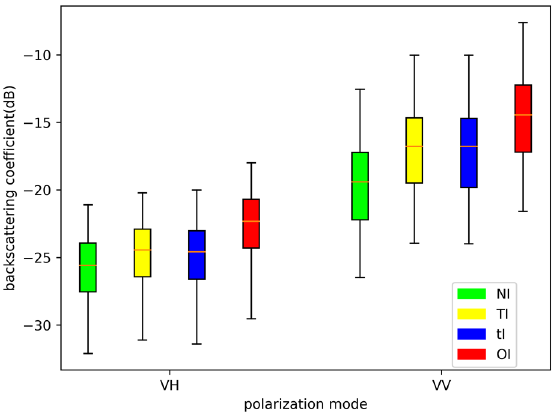
Figure 8. The backscatter coefficient statistics for four types of sea ice in scene 19.